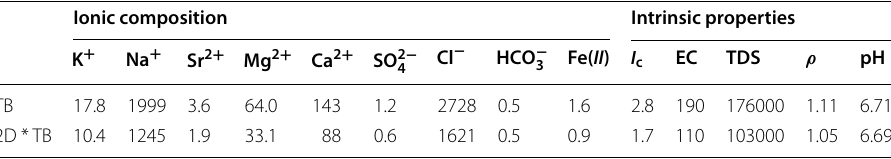
Table 1 Ionic composition in mmol/l, ionic strength I c in mol/l, electrical conductivity (EC) in mS/m, total dissolved solids (TDS) in ppm, density ( ρ ) in g/cm 3 , and pH Ionic